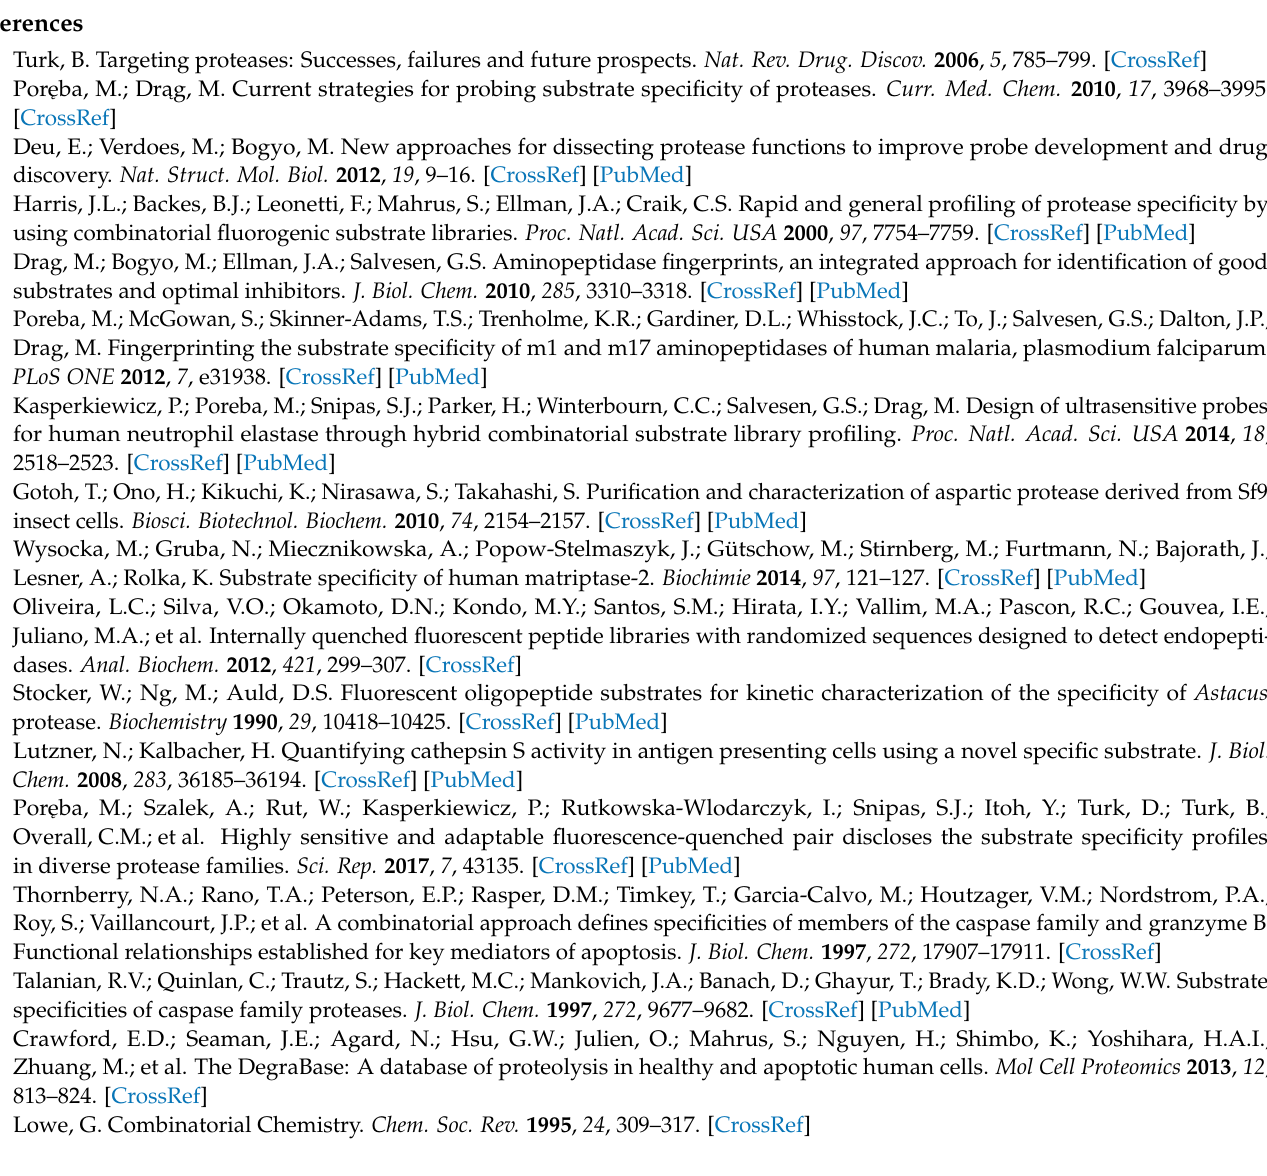
Glu-Val-Glu-OH conjugate. Parent ion m/z 643.28, collision energy 40 eV; Figure S9: ESI-MS/MS spectrum of DABCO+CH2CO-Asp-Glu-Val-Ala-OH conjugate. Parent ion m/z 585.29, collision en- ergy 40 eV; Figure S10: ESI-MS spectrum of model combinatorial library; Figure S11: Chromatograms for QA-DEVE-OH peptide investigated in supernatant after incubation with caspase 3. Analyzed transition 519.2 → 158.1; Figure S12: Schematic presentation of solid-phase peptide synthesis and derivatization with quaternary ammonium